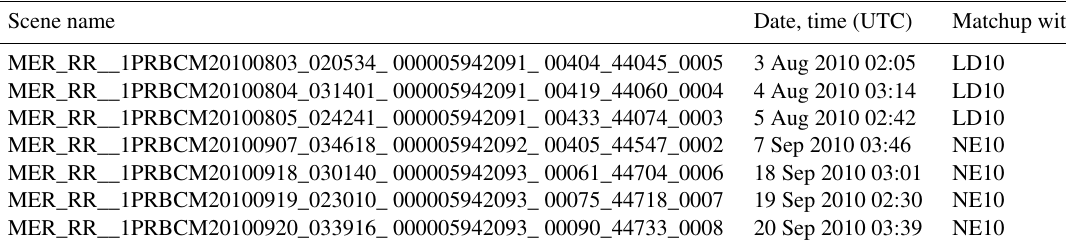
Table 2. List of Medium Resolution Imaging Spectrometer (MERIS) scenes used in this study. Scene